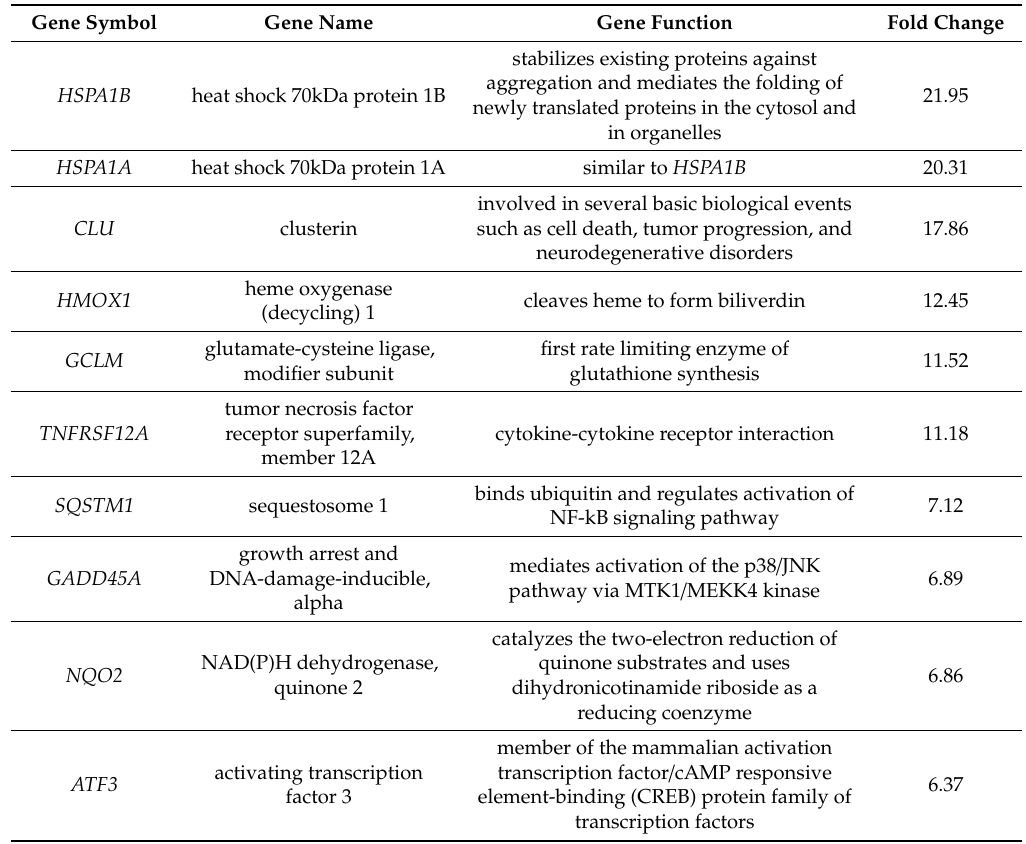
Table 4. The list of 10 most upregulated genes involved in apoptosis in bortezomib-treated SH-SY5Y cells compared to controls. Gene function according to NCBI Gene database.